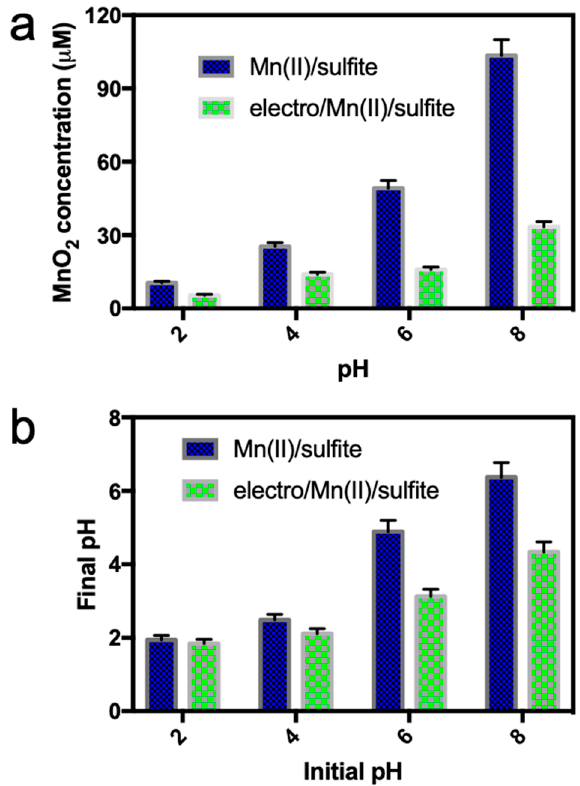
Figure7. QuantificationofproducedMnO 2 ( a )andmeasurementoffinalsolutionpH( b )inMn(II) / sulfite Figure 7. Quantification of produced MnO 2 ( a ) and measurement of final solution pH ( b ) in and electro / Mn(II) / sulfite processes at di ff erent initial pH. Reaction conditions: 0.2 mM Mn(II), 2 mM Mn(II)/sulfite and electro/Mn(II)/sulfite processes at different initial pH. Reaction conditions: 0.2 mM sulfite, 5 mM sulfate as supporting electrolyte, 10 µ M BPA, and 100 mA electric current. Initial solution Mn(II), 2 mM sulfite, 5 mM sulfate as supporting electrolyte, 10 μ M BPA, and 100 mA electric current. pH varied as Initial solution pH varied as indicated.